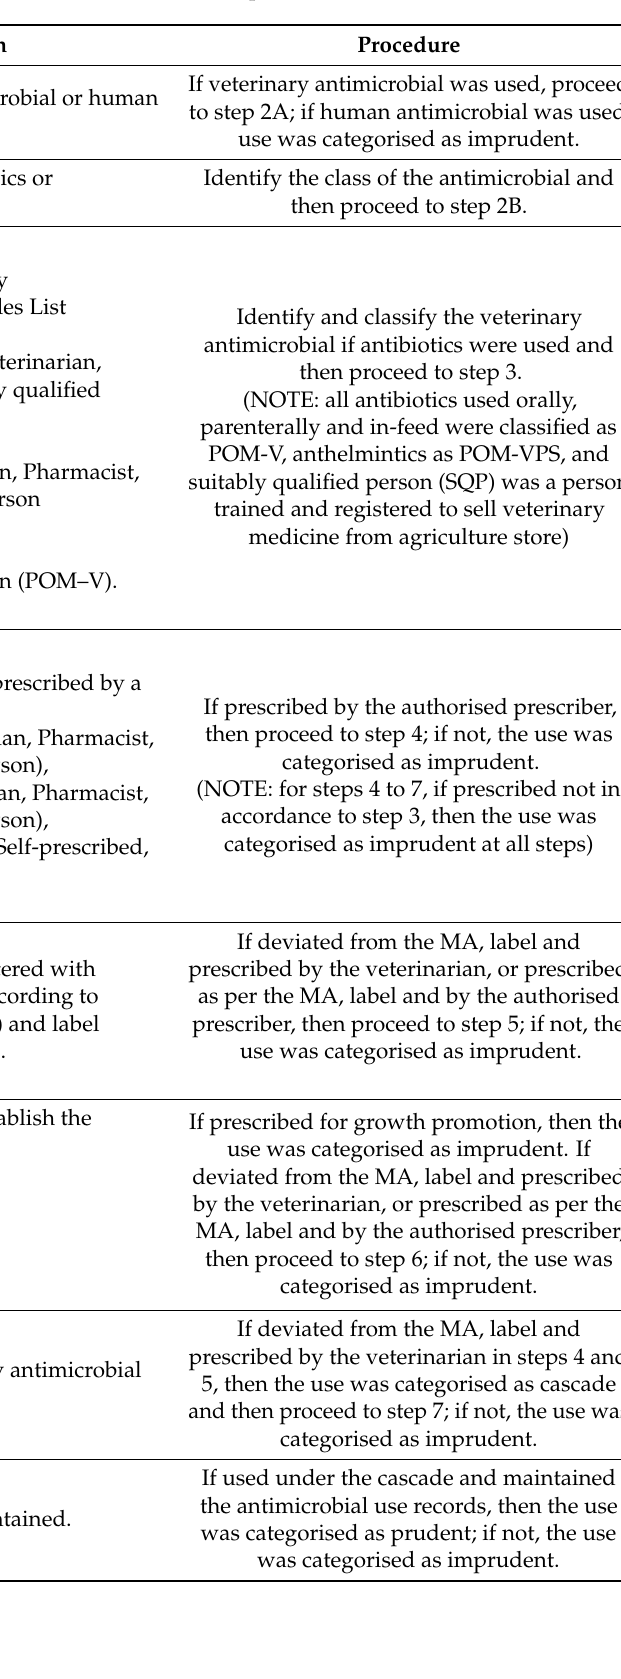
Table 5. Framework for categorisation of antimicrobial use practice in livestock